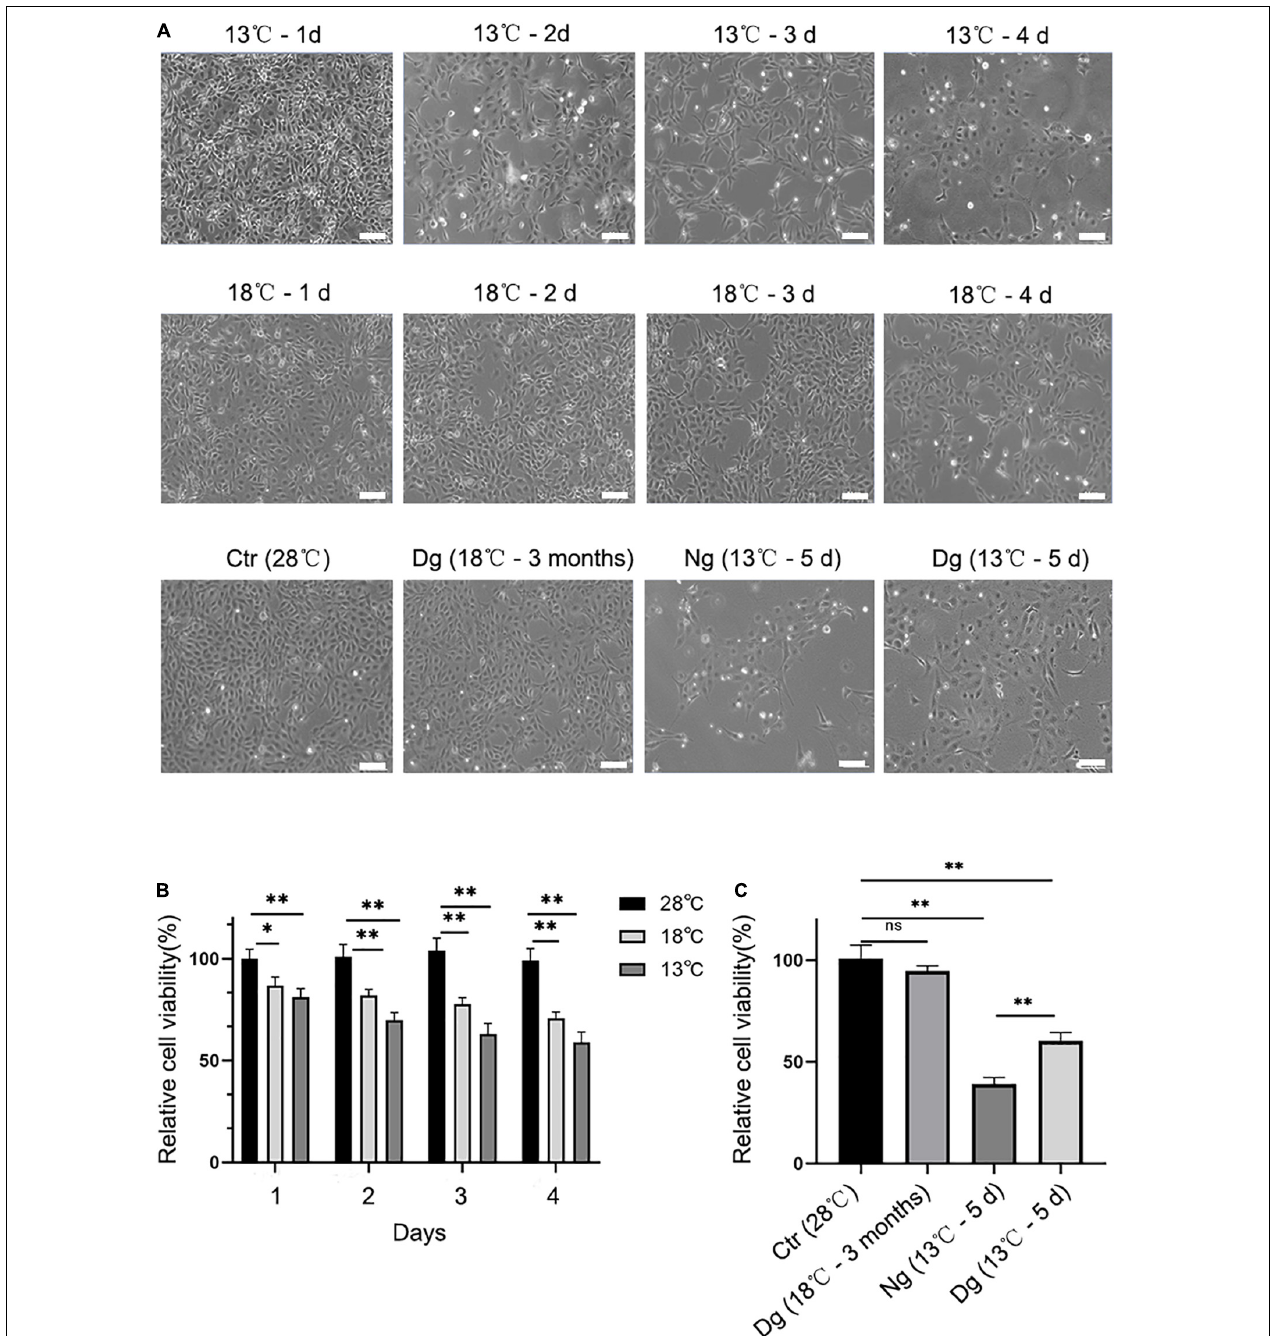
FIGURE 1 | Effect of cold stress on cell morphology and cell viability. Cells were allowed to grow in the incubator at 28 ◦ C in 5% CO2 and then treated with low temperature (13 and 18 ◦ C). Ctr, the control group; Dg, the domesticated group; Ng, the non-domesticated group. (A) Morphological pictures of ZF4 cells under normal or low temperature conditions. Cell morphology was examined under an inverted microscope at a 20 × magnification. Scale bar = 100 µ m. (B,C) The CKK-8 assay was used to measure the viability of groups of short-term low temperature stress and long-term low temperature acclimation cells. The experiments were repeated three times. The results are presented as the mean ± SD ( n = 6); ∗ P < 0.05, ∗∗ P <